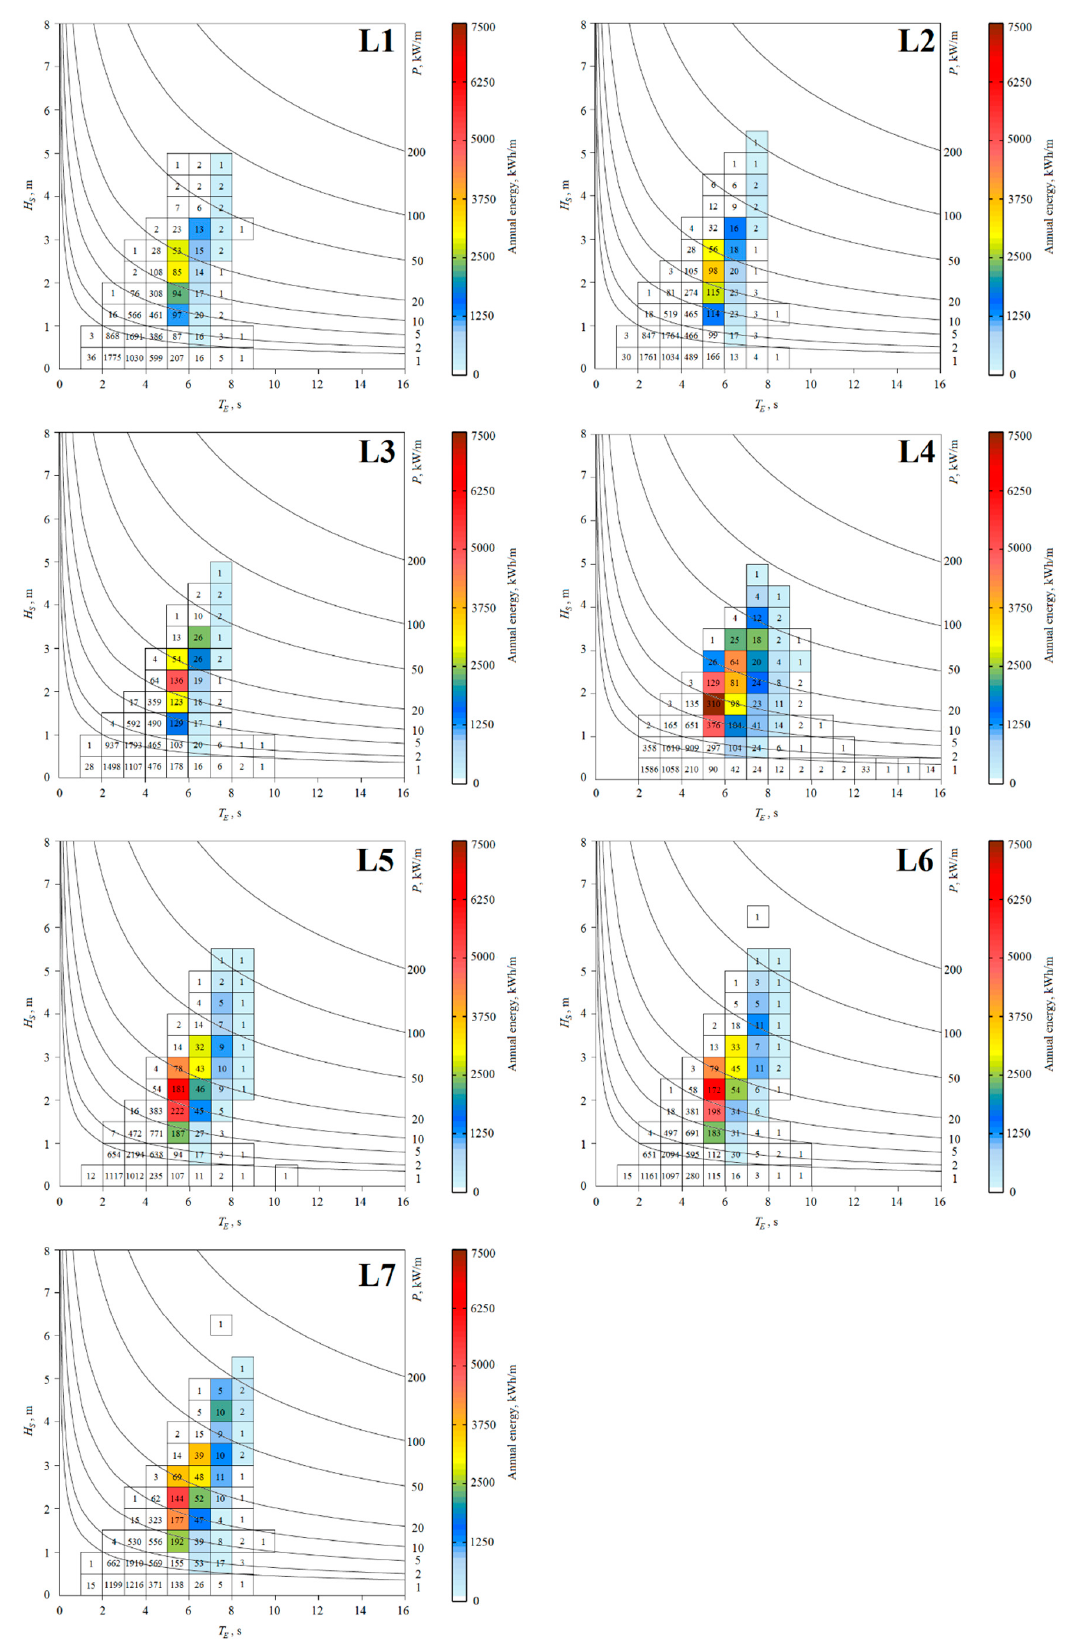
Figure 6. Characterisation of the annual wave energy at the investigated locations using the Aqua Buoy.